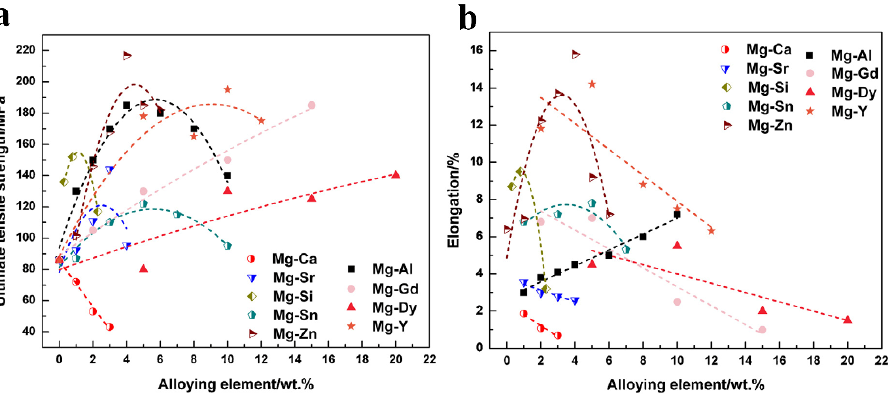
Figure 4. Summary of ( a ) ultimate tensile strength and ( b ) elongation of as-cast binary Mg-X alloys as a function of alloying element content. Reproduced with permission from [20]. Copyright 2014, Elsevier.